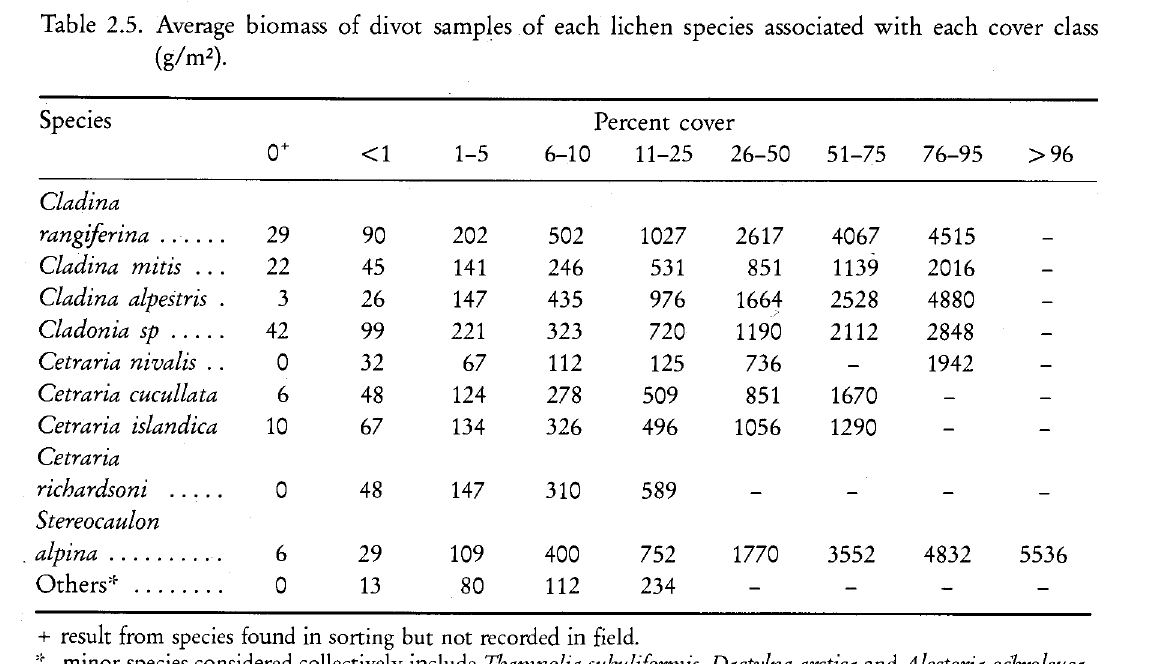
Table 2.5. Average biomass of divot samples of each lichen species associated with each cover class (g/m 2